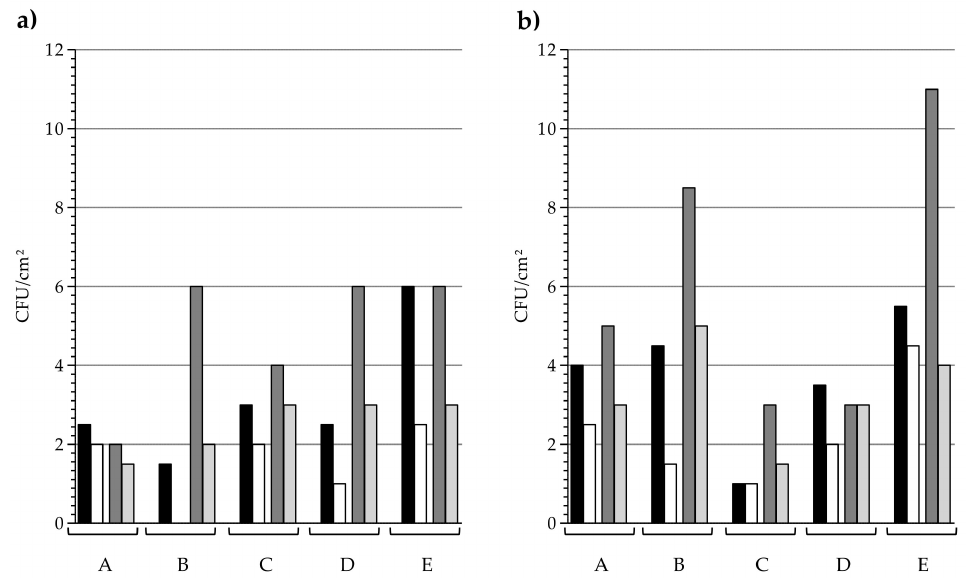
Figure 3. Sequence analysis: Bacterial burden recovered from ( a ) door handles and ( b ) handrails in each long-term care facility (A to E). Black bars, control sequence 1; White bars, copper sequence 1; Dark grey bars, control sequence 3; Light grey bars, copper sequence 3. 26 ≤ n ≤ 30. Median